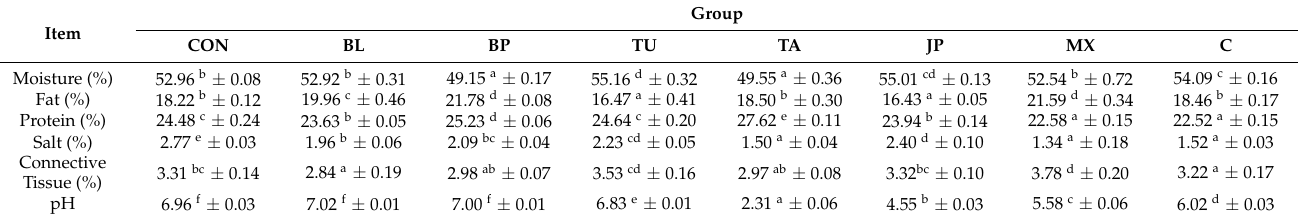
Table 5. The effect of marinade on basic chemical composition and pH (mean ± standard deviation) of grilled